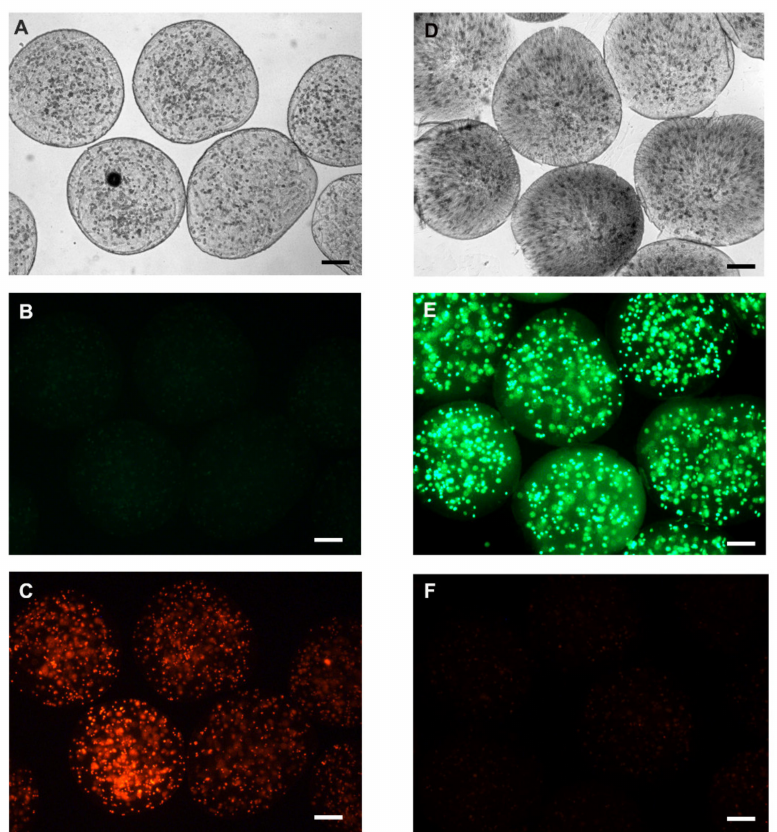
Figure 7. Representative fluorescence microscopy image with calcein-AM and propidium iodide. Initially, an assay for the negative cell viability control was performed. The cells were microencapsulated after incubation with 0.01% Triton X detergent for 5 min before encapsulation in the alginate membrane. ( A ) Clear field microscopy photo of dead encapsulated cells; ( B ) negative labeling for calcein-AM, and ( C ) cells with positive labeling for propidium iodide. Cell viability after encapsulation was verified by encapsulating HepG2 cells with viability greater than 90%. ( D ) clear field representation of cellular microencapsulation; ( E ) positive labeling for calcein-AM, representing cell viability after encapsulation, and ( F ) some cells labeled with propidium iodide. Representative photo of three experiments. Scale bar presents 100 µ